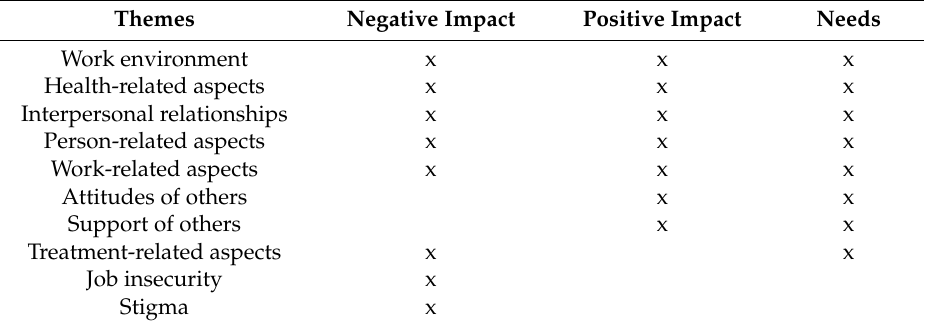
Table 3. Themes derived from Factors having a negative impact and Factors having a positive impact on work life as well as Needs to maintain a job or return to work marked with “x” in the respective column. Themes Negative Impact Positive Impact Needs Work environment x x x Health-related aspects x x x Interpersonal relationships x x x Person-related aspects x x x Work-related